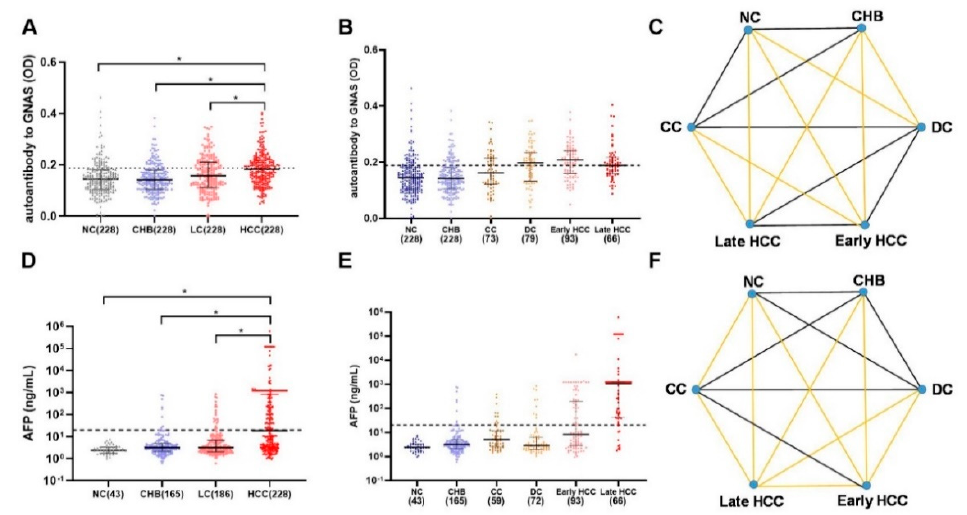
Figure 3. The scatter plots of autoantibody to GNAS and AFP in different groups of the development of HCC in the validation phase ( A , B , D , E ), the dots in different colors representing the different groups of the research objects. The statistical differences between each two groups in ( B , E ) are showed in ( C , F ). If the lines in ( C , F ) are yellow, the difference between groups of its two ends was considered to be significant ( p < 0.05, * p < 0.05 in A , D ). HCC: hepatocellular carcinoma; NC: normal control; LC: liver cirrhosis; CHB: chronic hepatitis B; CC: compensated liver cirrhosis; DC: decompensated liver cirrhosis; AFP: alpha-fetoprotein. The dotted line (y = 0.188) in Figure 3A,B shows the cut-off value of autoantibody to GNAS, while the cutoff value of AFP in Figure 3D,E was 20 ng/mL.